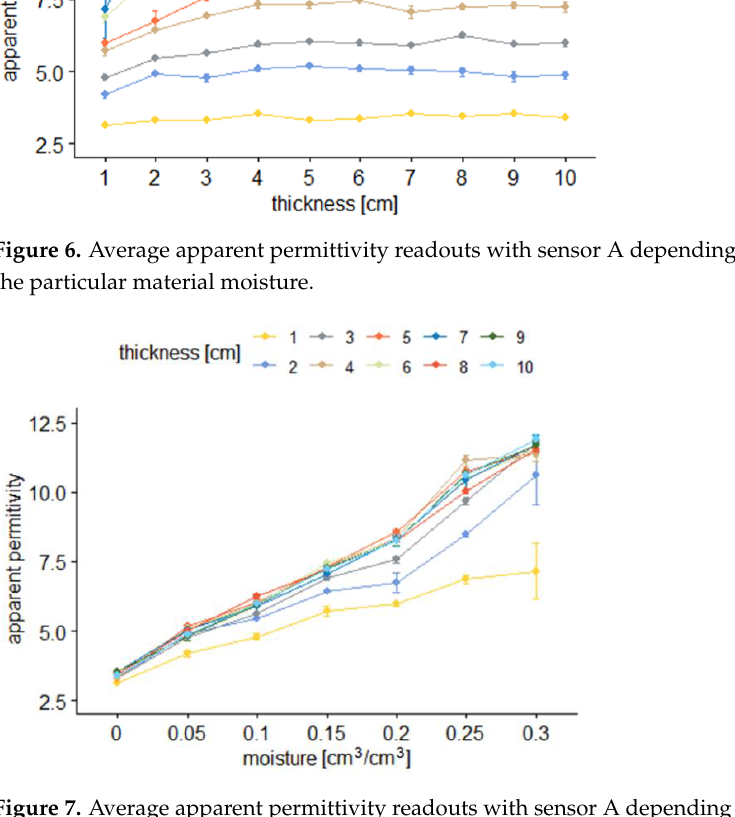
Figure 8. Average apparent permittivity readouts with sensor B depending on sample thickness for particular material moisture. Figure 9. Average apparent permittivity readouts with sensor B depending on the material moisture for particular sample thickness.